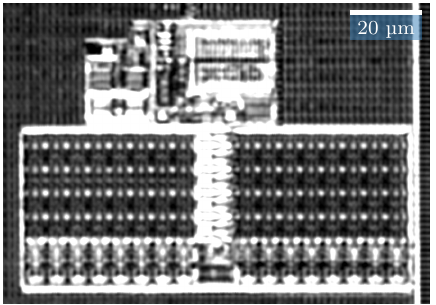
Figure 10: Reflected light image of the BBRAM AES key